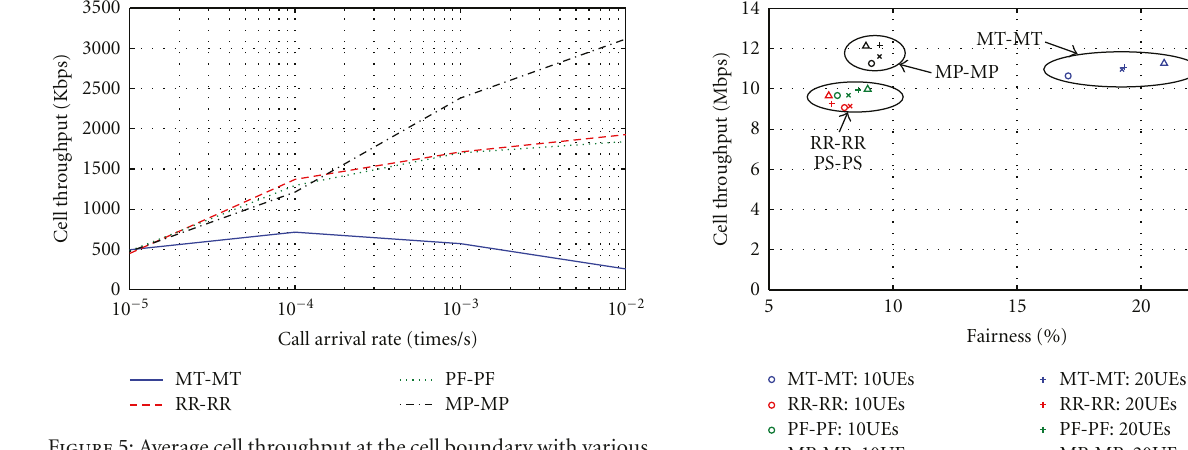
Figure 5: Average cell throughput at the cell boundary with various call arrival rates.